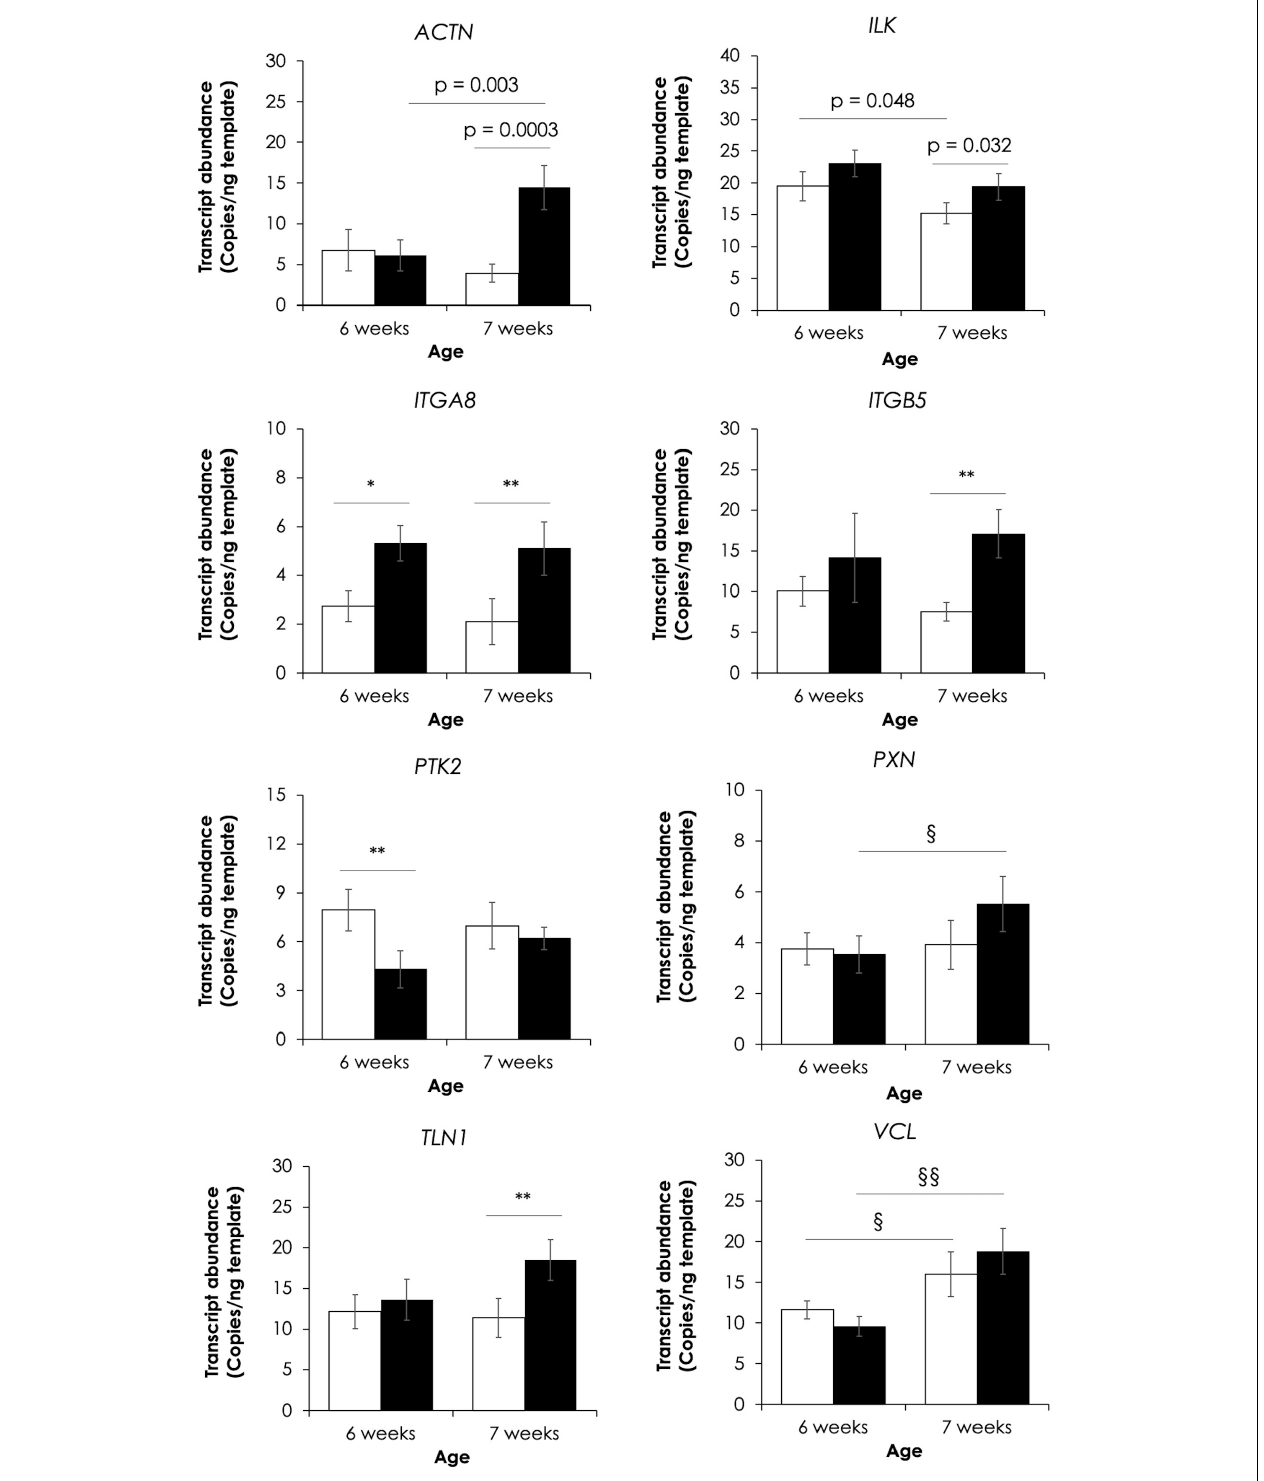
FIGURE 4 | Effects of wooden breast myopathy on absolute expression of eight genes in focal adhesion signaling. The genes include actinin-1 ( ACTN1 ), integrin-linked kinase ( ILK ), integrin subunit alpha 8 ( ITGA8) , integrin subunit beta 5 ( ITGB5 ), protein tyrosine kinase 2 ( PTK2 ), paxillin ( PXN ), talin 1 ( TLN1 ), and vinculin ( VCL ). Bars and error bars depict average and standard error in copies per nanogram cDNA template. * p < 0.05, ** p < 0.01 between non-WB and WB samples. § p < 0.05, §§ p < 0.01 between different ages.